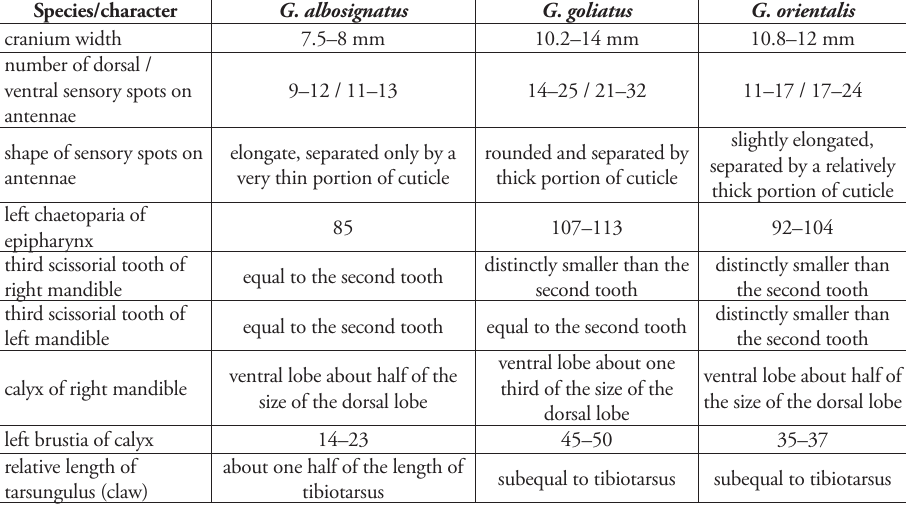
Table 2. Main diagnostic characters for larvae of Goliathus species.